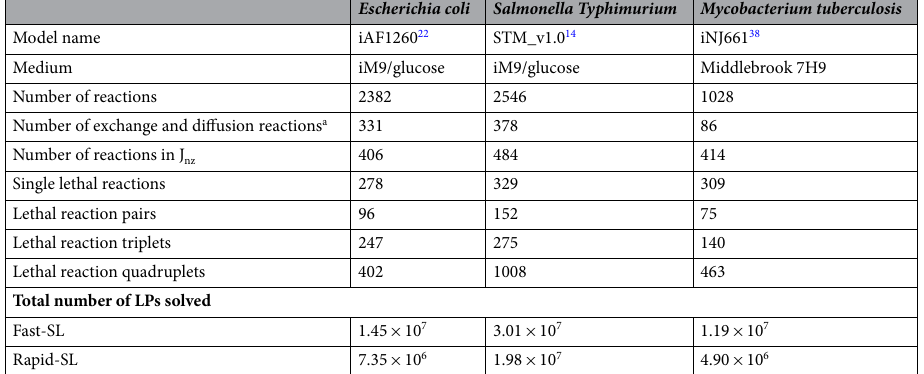
Table 1. Comparison of the number of LPs solved by Rapid-SL vs. Fast-SL for three GEMMs. a The exchange and diffusion reactions are not generally considered in the lethality